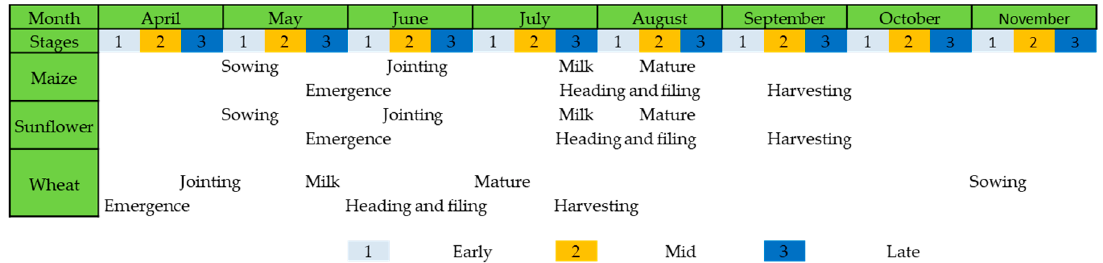
Figure 4. Seasonal maize, sunflower and wheat calendar of the region.